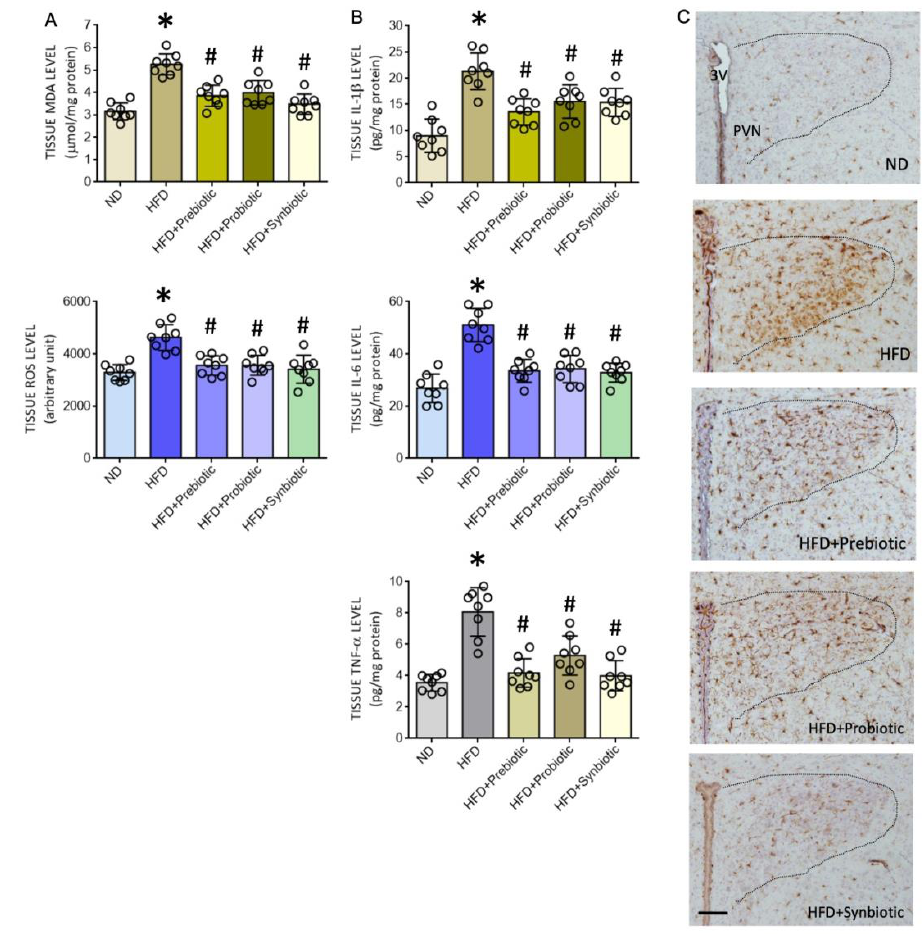
Figure 2. Tissue malondialdehyde (MDA) or reactive oxygen species (ROS) levels ( A ), levels of proinflammatory cytokines interleukin 1- β (IL-1 β ), interleukin 6 (IL-6), and tumor necrosis factor α (TNF- α ) ( B ), and representative photomicrographs showing the distribution of Iba1-immunoreactive cells ( C ) in the hypothalamic paraventricular nucleus (PVN) of adult ND or HFD offspring that received oral supplementation of FOS (4 g/kg/day, probiotic), L. gasseri (3 × 10 6 CFU/mL/day, probiotic) or FOS+ L. gasseri (synbiotic) was initiated at the age of 6 weeks. Data are presented as mean ± SD, n = 8 in each group. * p < 0.05 vs. ND group, and # p < 0.05 vs. HFD group in the post hoc Tukey’s multiple-range test. 3 V, third ventricle; PVN, hypothalamic paraventricular nucleus. Scale bar in ( C ): 200 µ